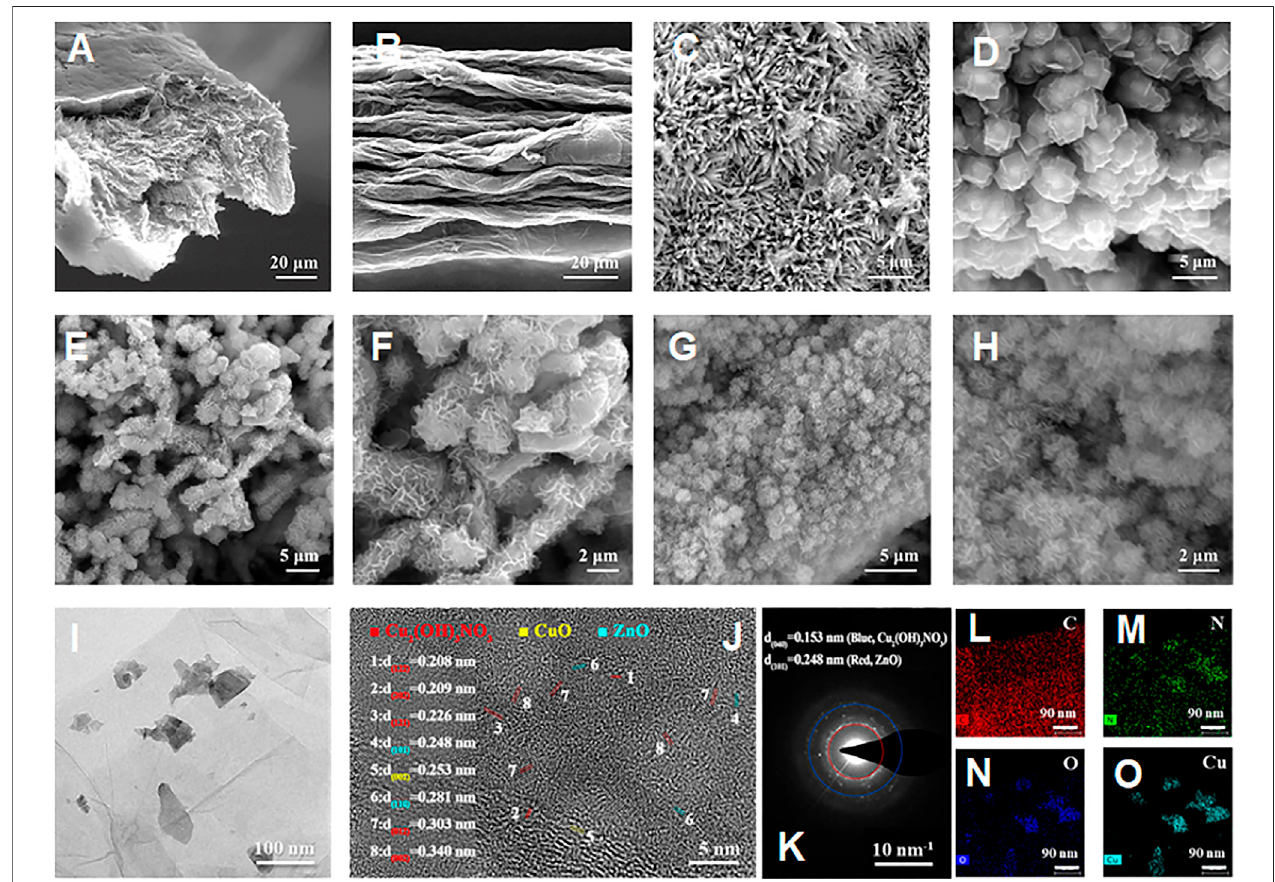
FIGURE 2 | SEM images of (A) cross-sectional view and (B) front view of the AGF; SEM images of (C) ZnO/AGF and (D) ZIF-8@ZnO/AGF; SEM images of (E – H) Cu 2 (OH) 3 NO 3 @ZnO/AGF at different magni fi cations; TEM image of (I) Cu 2 (OH) 3 NO 3 @ZnO/AGF; (J) HRTEM image and corresponding (K) SAED pattern of